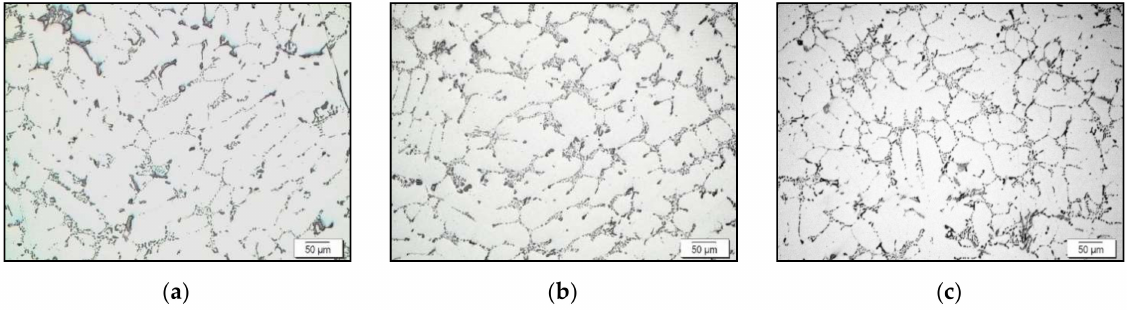
Figure 5. Microstructure of hypoeutectic alloy with copper, Alloy 1: ( a ) untreated; ( b ) standard flux; ( c ) complex flux.